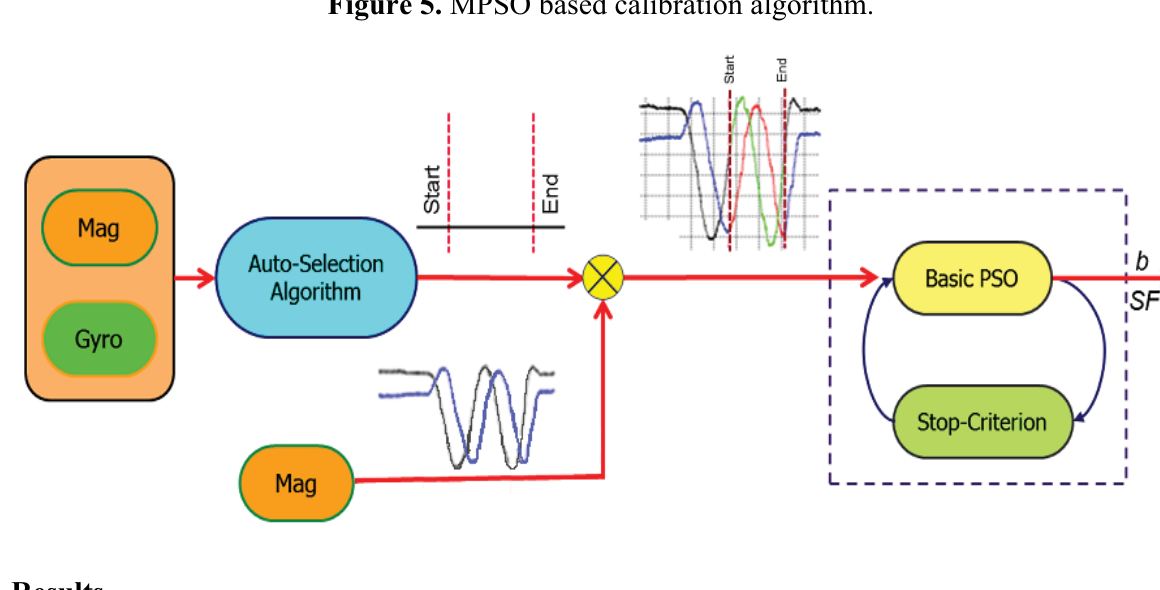
Figure 5. MPSO based calibration